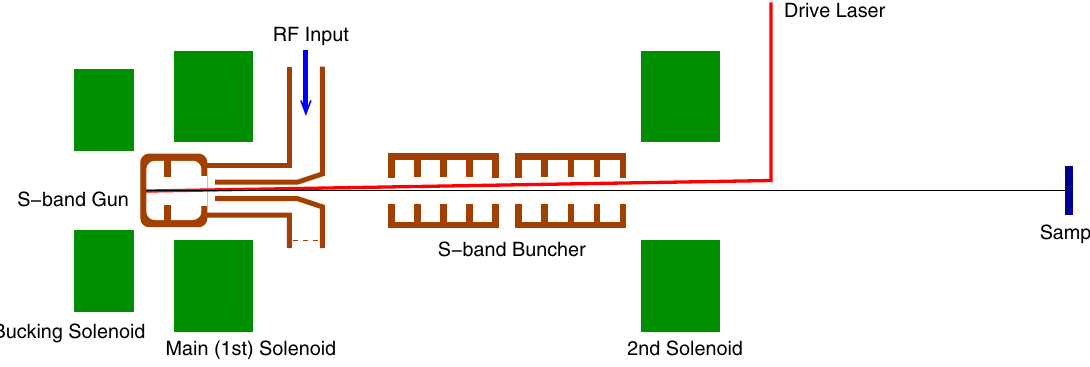
FIG. 1. Layout of the beam generation setup for relativistic femtosecond electron diffraction experiments. The setup consists of an S-band photocathode gun, an S-band buncher, focusing solenoids, and a drive laser. A sample is placed at 1.6 m from the cathode. A detector for electrons diffracted from the sample should be a few meters downstream of the sample (not shown